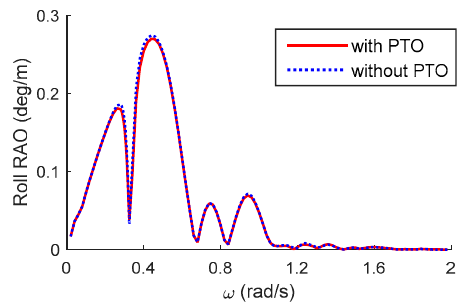
Figure 9. Platform roll RAOs in the case of 22.5 deg wave-heading angle.